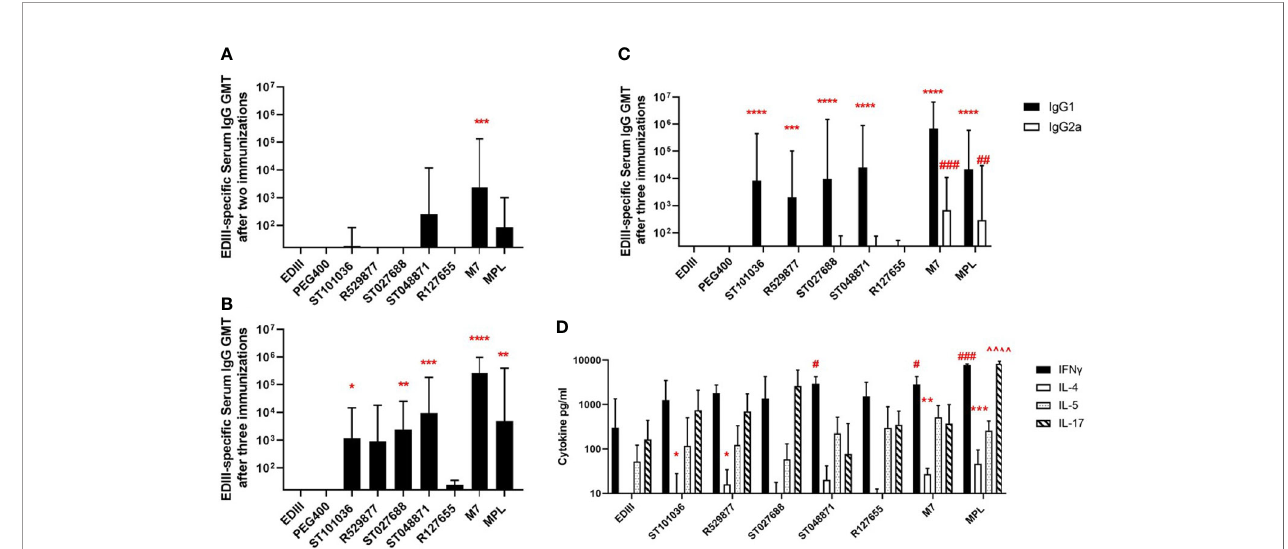
FIGURE 5 | Small molecule mast cell activators provide nasal adjuvant activity when co-administered with WNV EDIII. Female BALB/c mice (n = 5 mice per group) were nasally immunized with EDIII alone in saline or PEG400 or combined with MCAs, MPL, or M7. Vaccines were administered on days 0, 7, and 21. Serum collected after two immunizations were measured for EDIII-speci fi c IgG (A) , while serum collected after three immunizations was measured for EDIII-speci fi c IgG (B) , IgG1 (*), and IgG2a (#) (C) . EDIII-induced cytokine responses were measured in splenocytes after immunization [statistical indicators for each cytokine; IL-4 (*), IFN- g (#), and IL-17 (^)] (D) . One-way ANOVA was used to determine if adjuvants statistically increased EDIII-speci fi c antibody responses compared to mice immunized with EDIII in saline. *p < 0.05, **p < 0.01, ***p < 0.001, ****p < 0.0001. Antibody responses represent the geometric mean titer + geometric SD. Cytokine (pg/ml) responses are presented as mean + SD. The # denotes signi fi cant differences in IFN-g responses and ^ denotes signi fi cant differences in IL-17 responses. The number of # or ^ denotes the range of the p-value. ## p < 0.01 IFN-g, ### p < 0.001 IFN-g, and #### p < 0.0001 IFN-g. ^^^^p < 0.0001